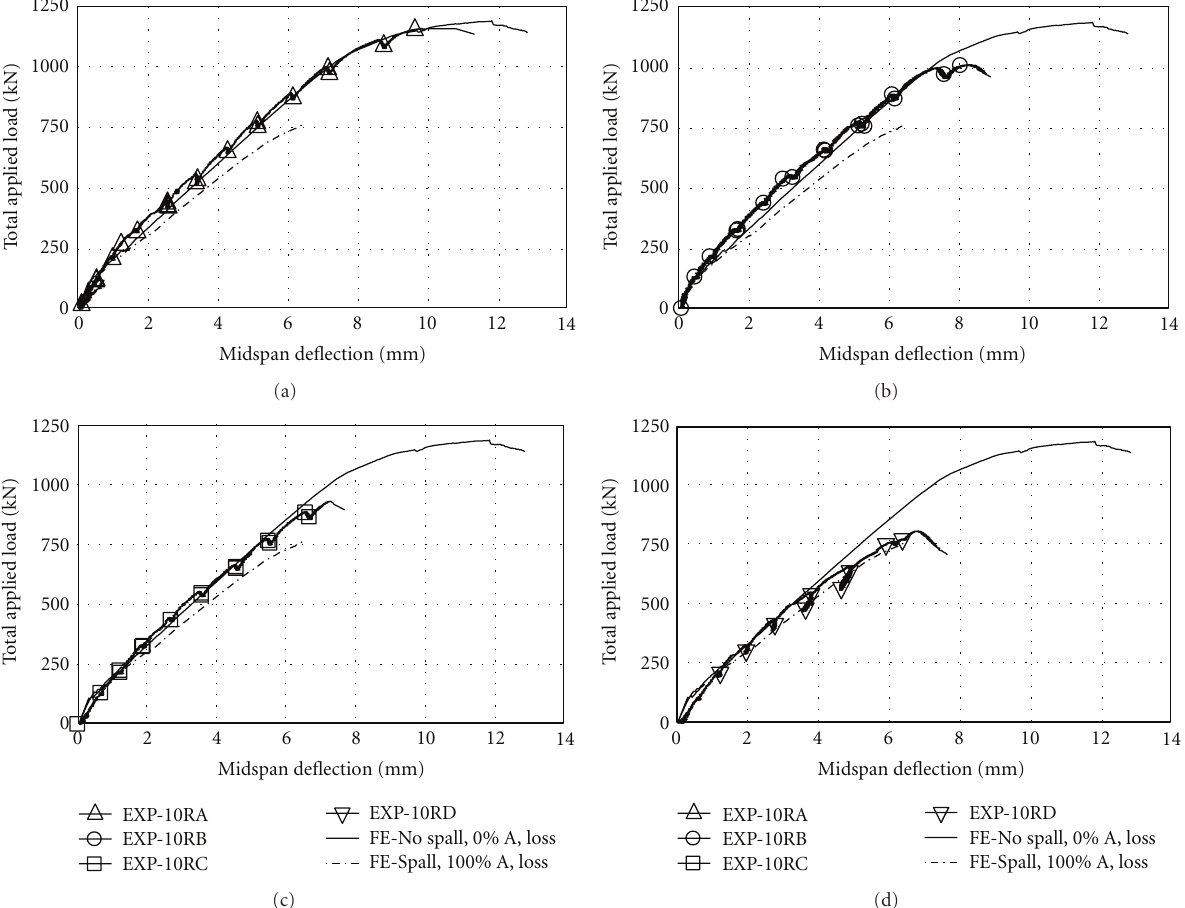
Figure 3: Load-deflection response for experimental results and FE models.